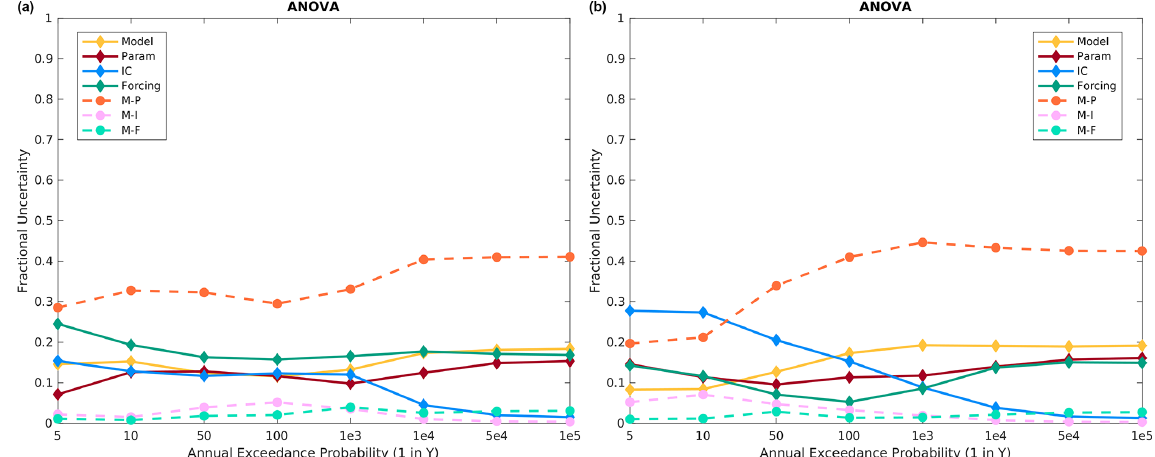
Figure 13. Altus fractional variance contributions for the two most disparate flood responses, namely SAC-SMA (model 3) and a SAC- SMA/HEC-HMS combination (model 6), for the (a) specified meteorological sequence and (b) historical meteorological